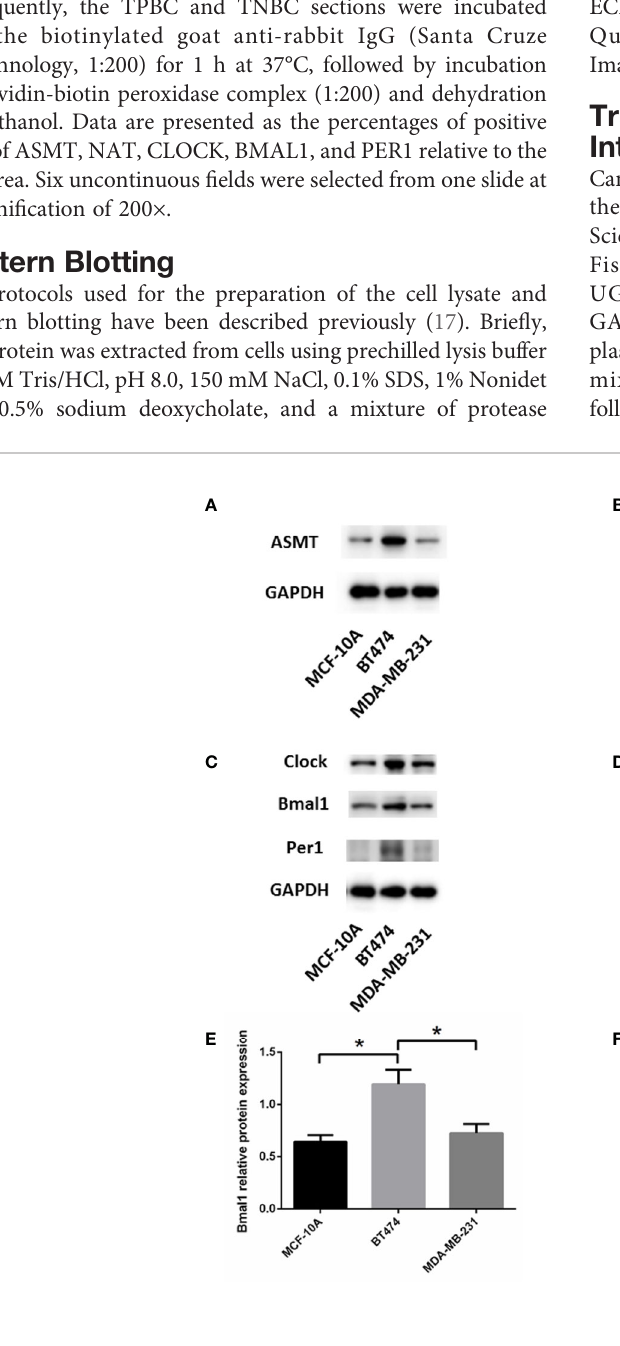
FIGURE 3 | Expression of ASMT and the circadian clock proteins increases in BT-474 compared with MDA-MB-231 and MCF-10A cells. (A, B) ASMT expression measured by Western blotting and quanti fi cation of ASMT level relative to GAPDH. (C – F) CLOCK, BMAL1 and PER1 expressions measured by Western blotting and quanti fi cation of the circadian clock system levels relative to GAPDH. Data are the mean ± SEM (n = 3). *p < 0.05, **p <